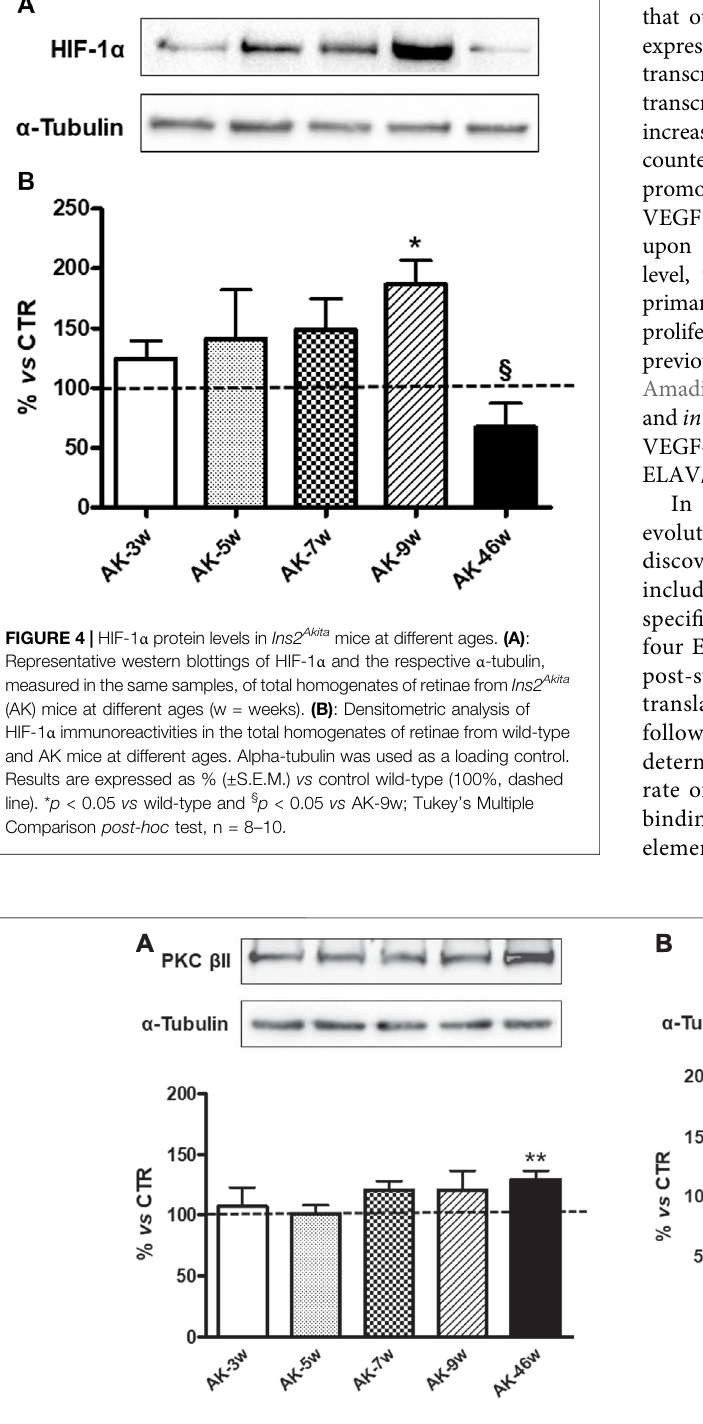
Frontiers in Pharmacology |